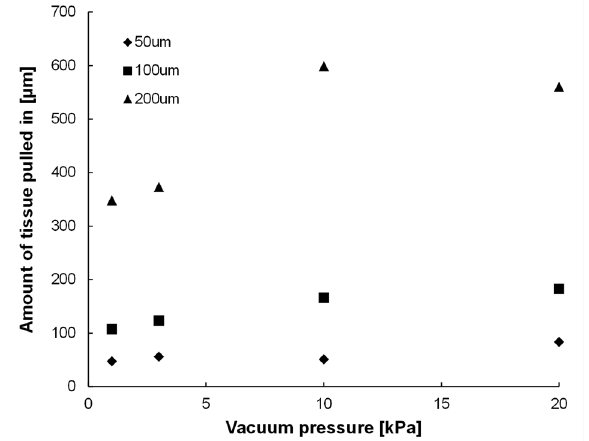
Figure 6. The amount of normal human cardiac fibroblast (NHCF) 3D tissues pulled into one vacuum hole by various vacuum pressures for three sizes of the square‐shaped holes, 50 μm, 100 μm, and 200 μm. The amount was defined as the distance between the tip of the pulled‐in NHCF 3D tissue and the hole opening. The amount of pulled‐in 3D tissues tended to increase with increasing vacuum pressure, and it also increased with increasing size of the hole.